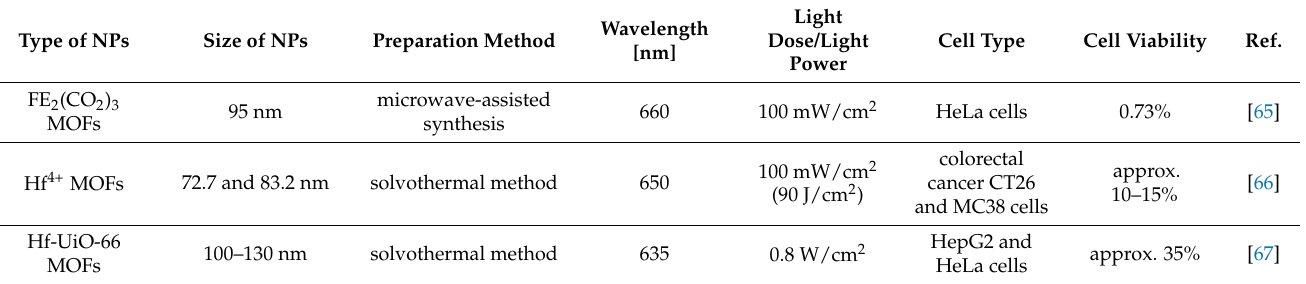
Table 6. Summary of the data presented in Section